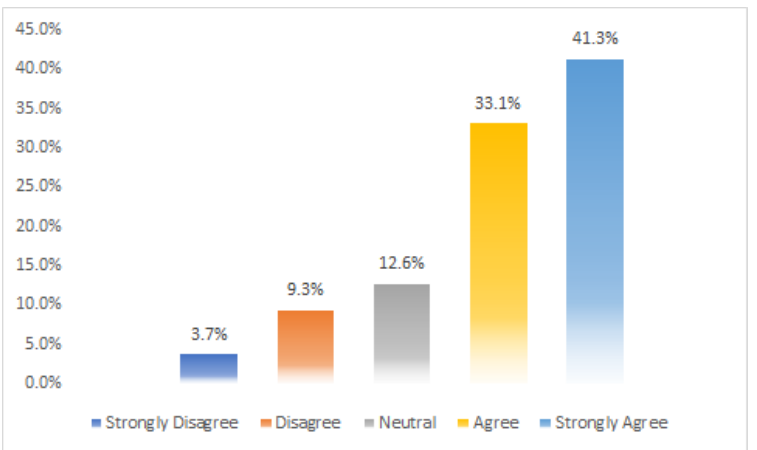
Figure 12. Answers to a Likert five-point scale to the question: Do you think that these types of activities are beneficial for the development of competencies such as teamwork or critical thinking?